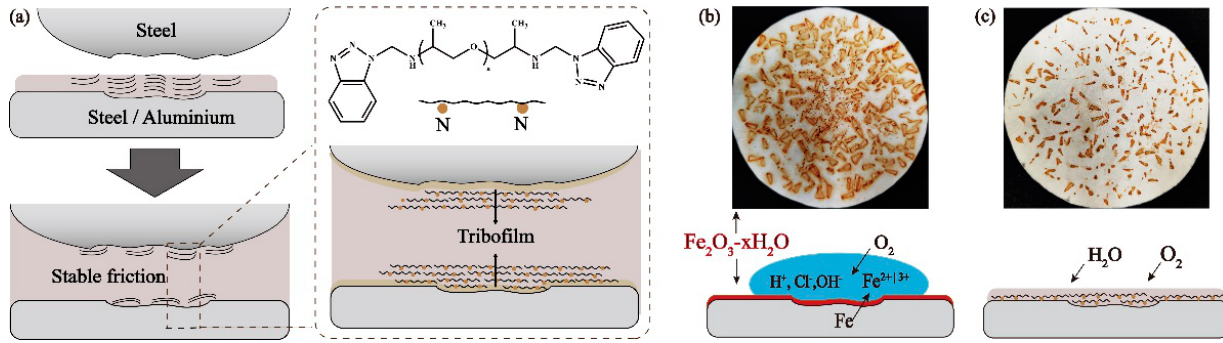
Figure 19. ( a ) Lubrication mechanism; ( b ) corrosion mechanism; and ( c ) anti-rust mechanism.